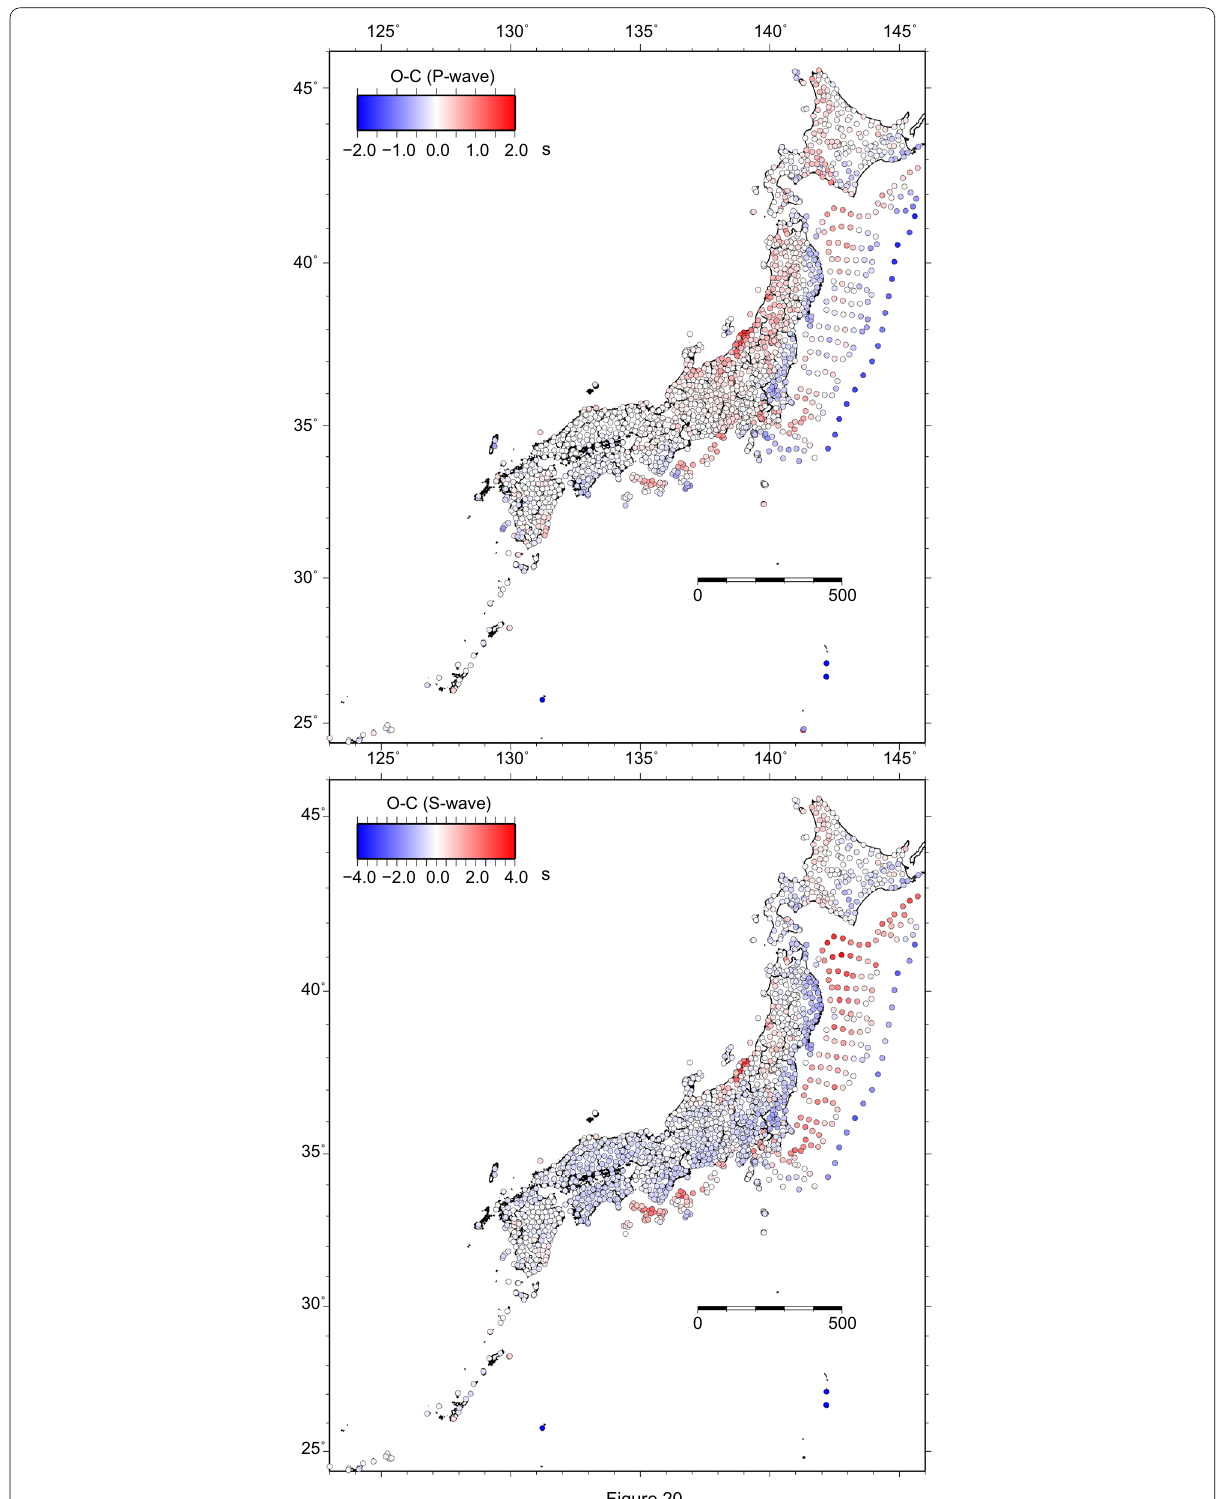
Fig. 20 Station corrections for Vp and